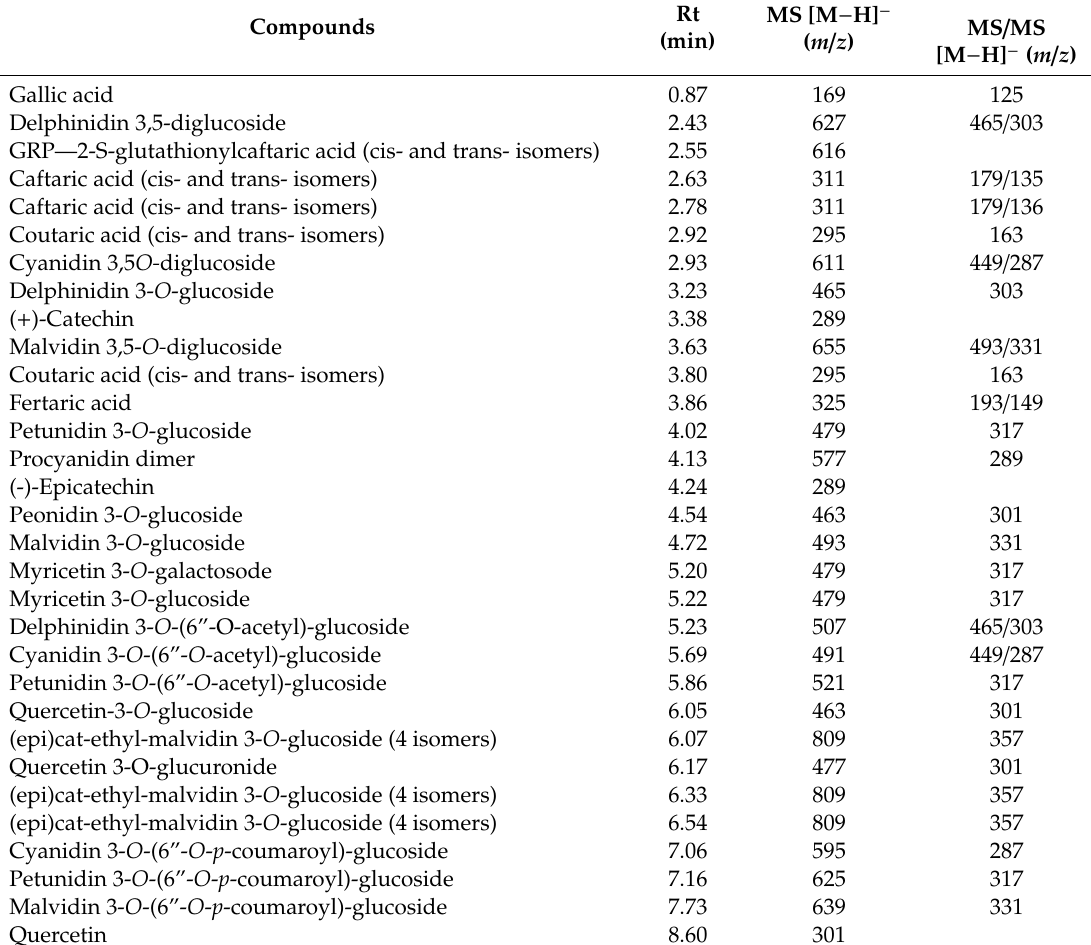
Table 3. The identification of phenolic compounds of “Regent” wine by retention time (Rt) using their spectral characteristics in ultra-pressure liquid chromatography with photodiode array and mass